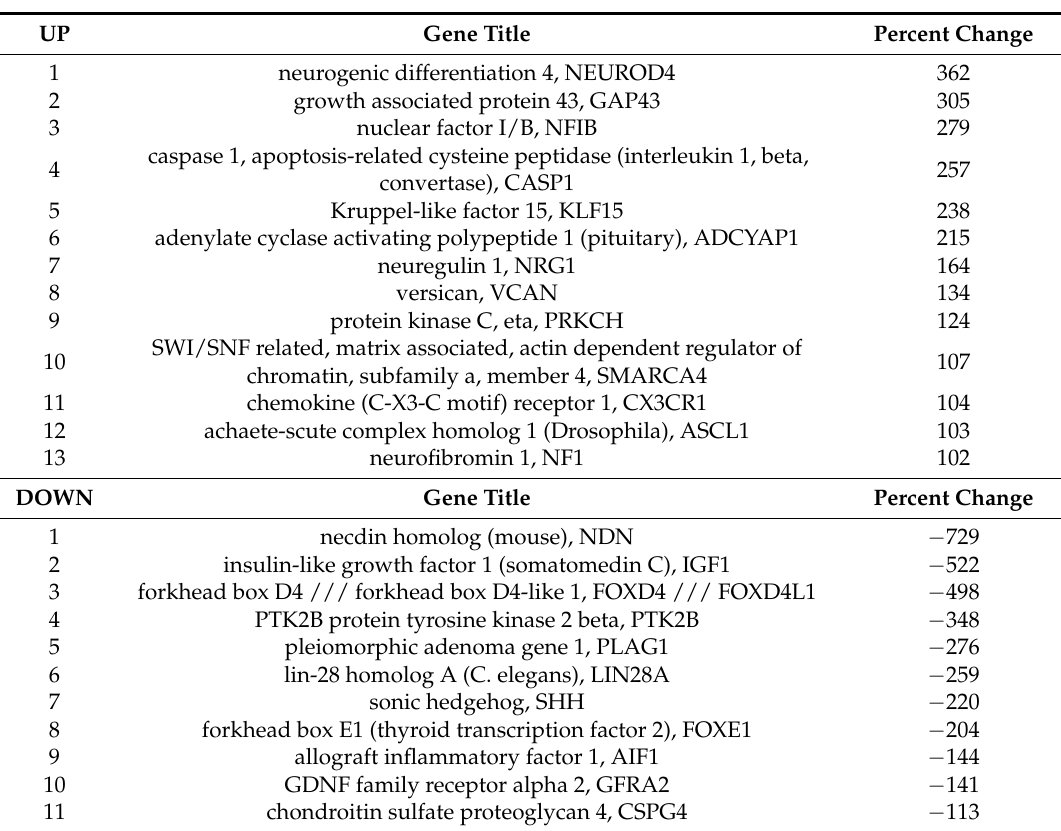
Table 16. GHK and Genes Associated with Glial